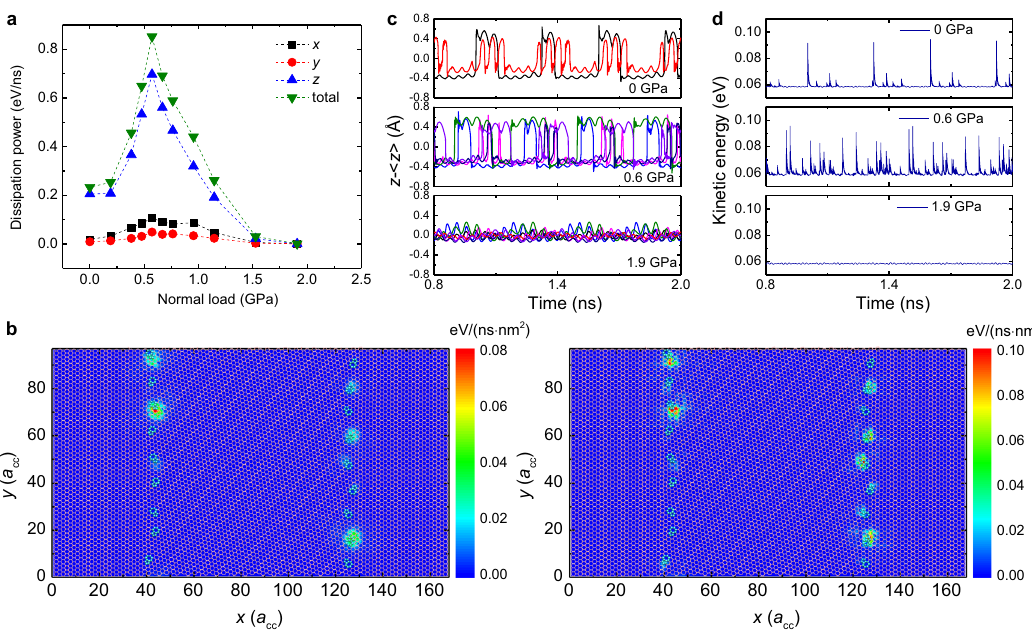
Fig. 3 Mechanism of the load dependence of frictional dissipation at zero temperature. a Total dissipation power and its directional contributions ( x , y , z — see Fig. 1a) as a function of normal load. b Spatial distributions of dissipation power density in the z direction of the second pristine layer (left panel) and the fi fth pristine layer (right panel) under a normal load of 0 : 6GPa. The geometric con fi guration of the PolyGr layer is superimposed on the 2D maps. The pentagon – heptagon atoms are shown in cyan and the hexagon carbon atoms are represented in pink. The power density is calculated based on area elements with size of a 2 ( a cc ¼ 1 : 42039Å is the equilibrium C – C bond length in the REBO potential). c Representative dislocation trajectories (for two cc sliding periods at steady state) corresponding to the out-of-plane motion of the atoms with maximal RMS corrugation within each dislocation (different colors correspond to different dislocations) during sliding, under normal loads of 0 ; 0 : 6 ; and 1 : 9GPa (from top to bottom panels, respectively). Substantial buckling and unbuckling dynamics during sliding is observed under normal loads of 0 and 0 : 6GPa. d Kinetic energy pro fi les corresponding to the traces appearing in panel ( c ). More details regarding the temperature effects on dislocation buckling can be found in Supplementary Note 3. Movies of typical simulations are also provided in the Supplementary